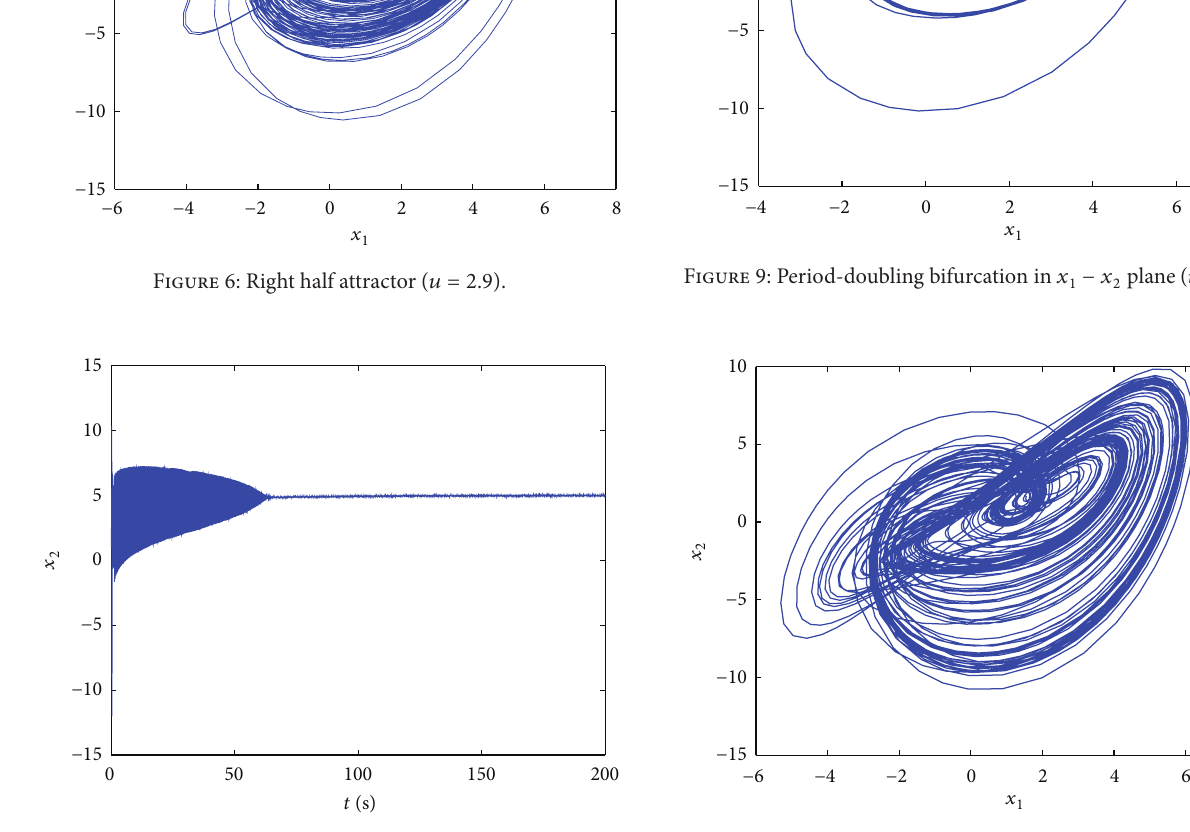
Figure 7: State trajectory of 𝑥 2 (𝑢 = 10) .